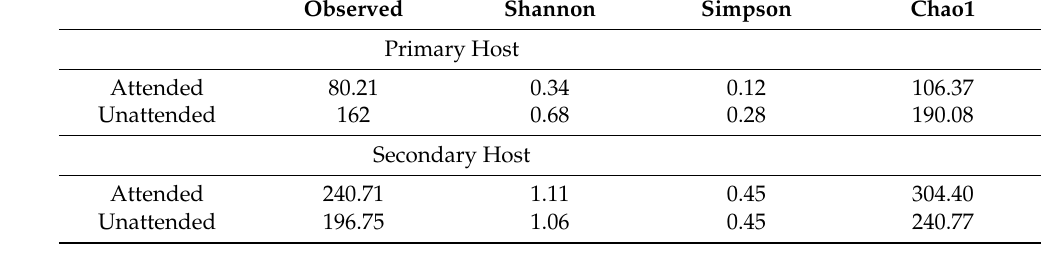
Table 2. Values of alpha diversity indicators of symbionts in reference to ant attendance and host plant.